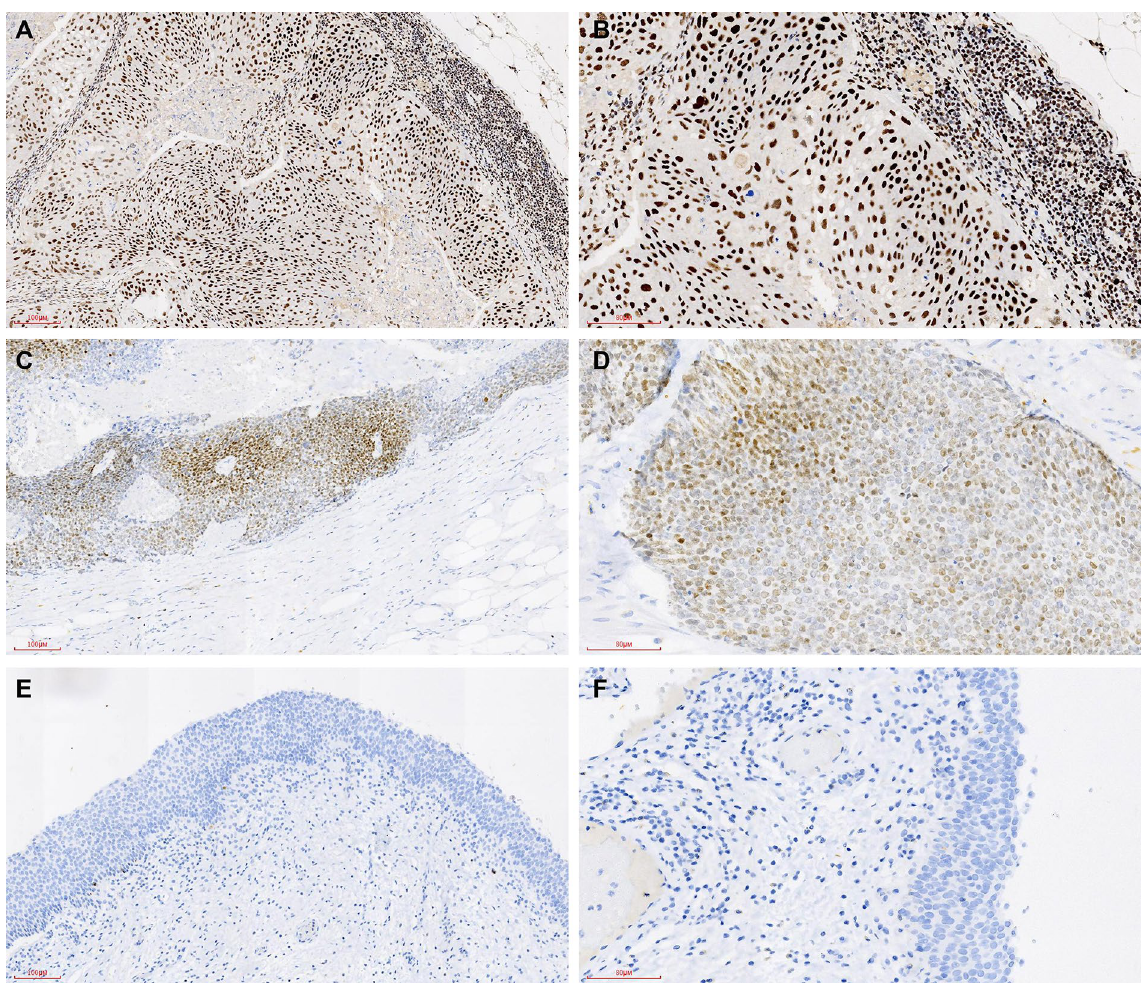
Figure 1. NUSAP1 expression in bladder cancer positive lymph node tissues was significantly higher as compared to the corresponding BUC primary foci tissue; NUSAP1 expression in BUC tissue was significantly higher as compared to the corresponding normal bladder tissues “( A , B Positive lymph nodes; C , D BUC; E , F Normal bladder tissues; A , C , E , ×100; B , D , F , ×200)”.